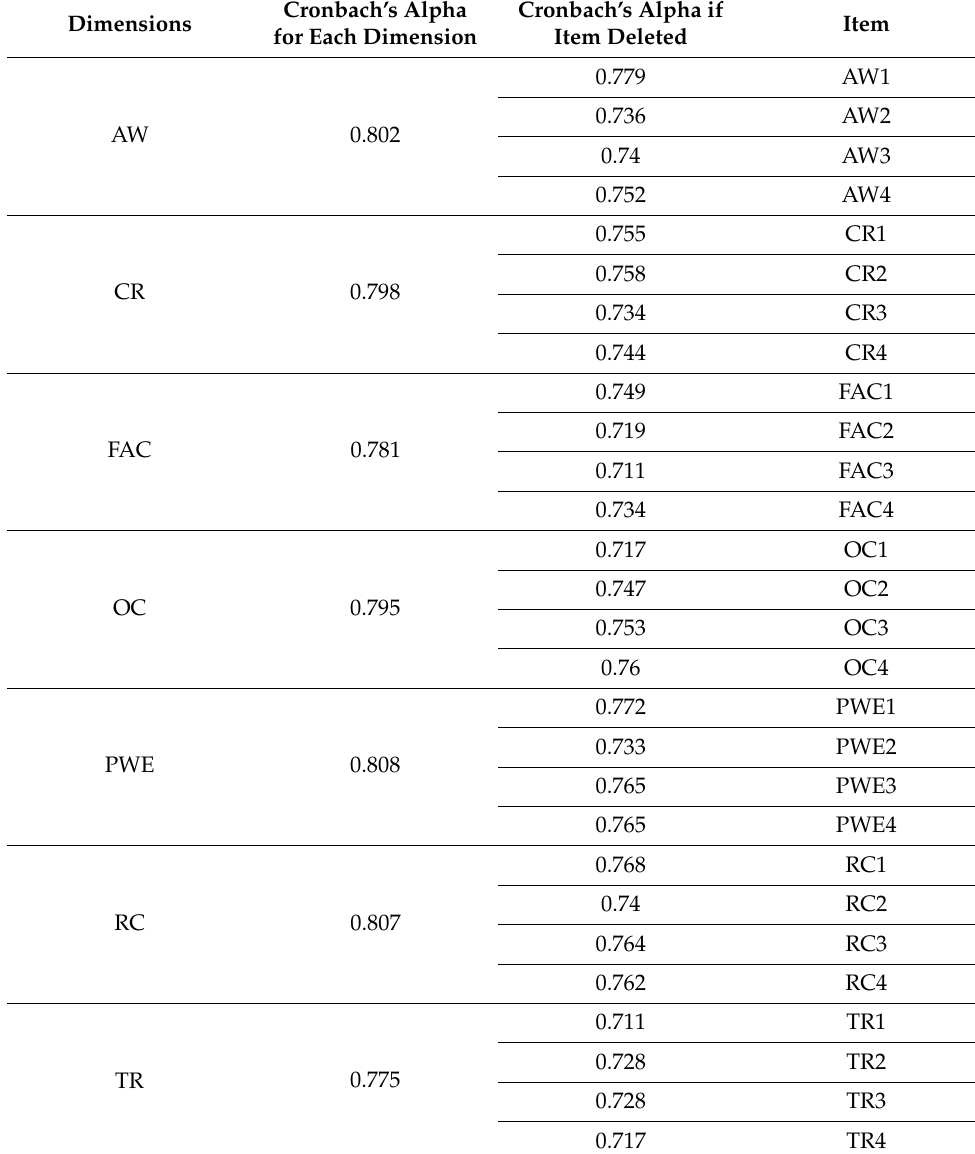
Table 3. QWL dimensions and subdimensions and their reliability tests. Cronbach’s Alpha Dimensions for Each